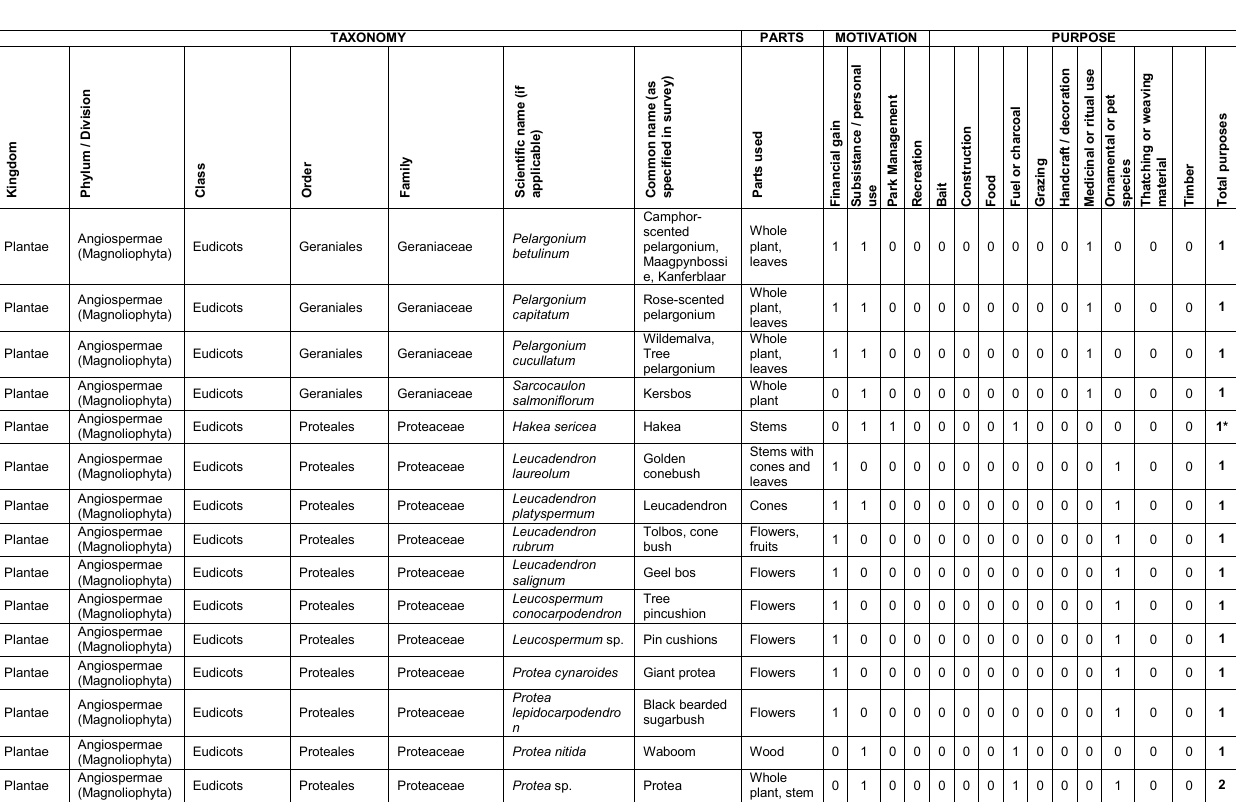
Protea Black bearded lepidocarpodendro sugarbush Flowers 1 0 0 0 0 0 0 0 0 0 0 1 0 0 1 n